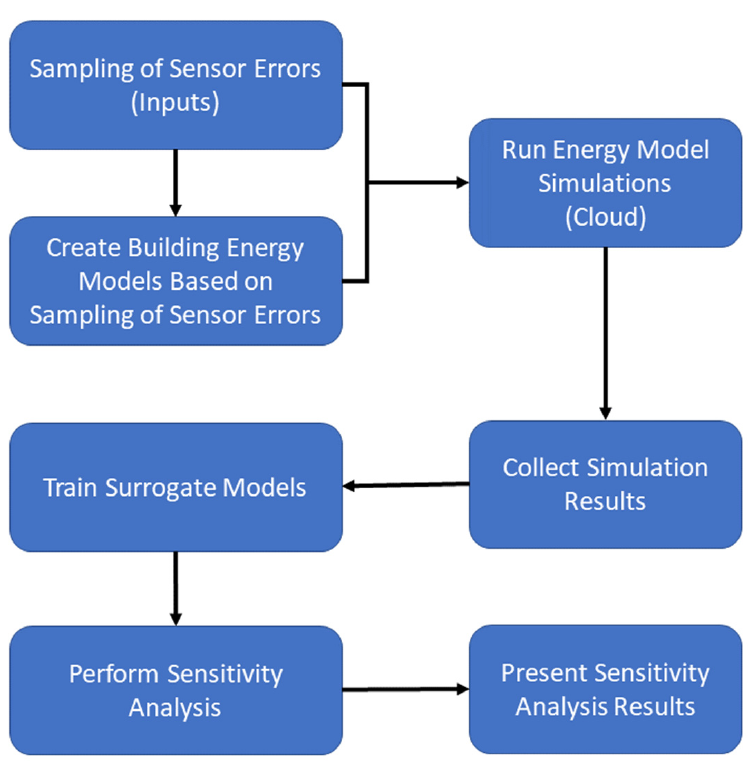
Figure 16. Sensitivity analysis flowchart.